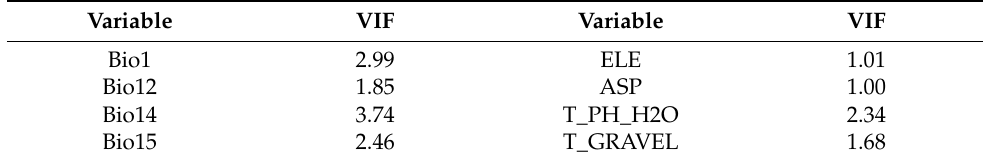
Figure 2. Correlation of 28 environmental factors. ( a ) Correlation of environment factors; ( b ) Correlation of soil factors. Table 2. Variance inflation factor of eight